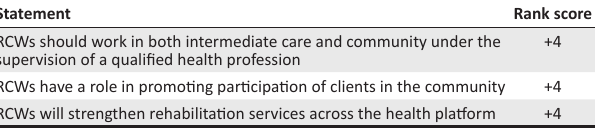
TABLE 4: The statements that participants loading onto Factor 2: ‘Promoters of participation’ strongly agreed with. Statement